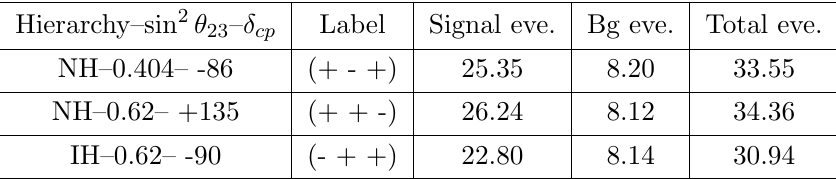
Table 4 . Number of expected (cid:23) e appearance events for one year (cid:23) run of NO (cid:23) A, for the three solutions in ref.